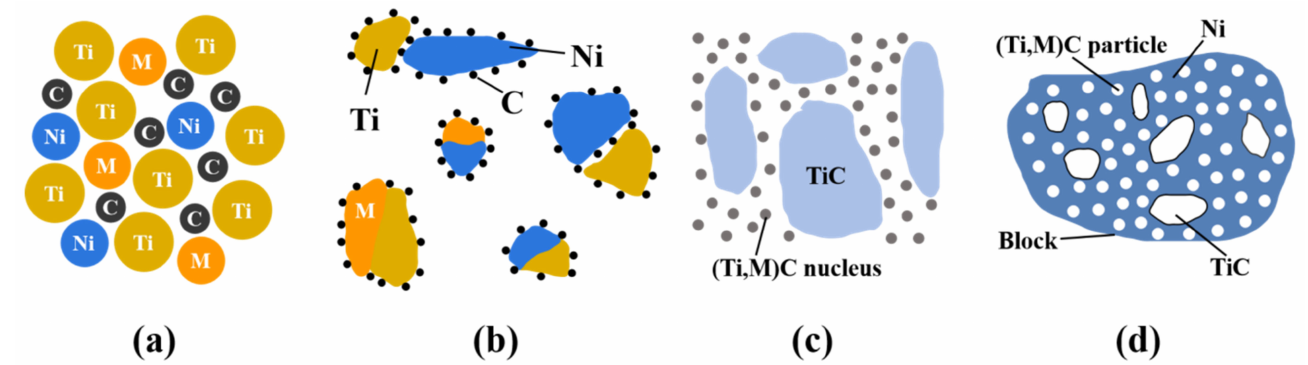
Figure 10. Schematic diagram of the preparation of the Ti-MC-Ni system: ( a ) Initial powders are mixed uniformly, ( b ) The powders are refined and activated, ( c ) The combustion reaction begins, and the melt appears ( d ) The melts merge and solidify during the cooling stage, forming a porous block.